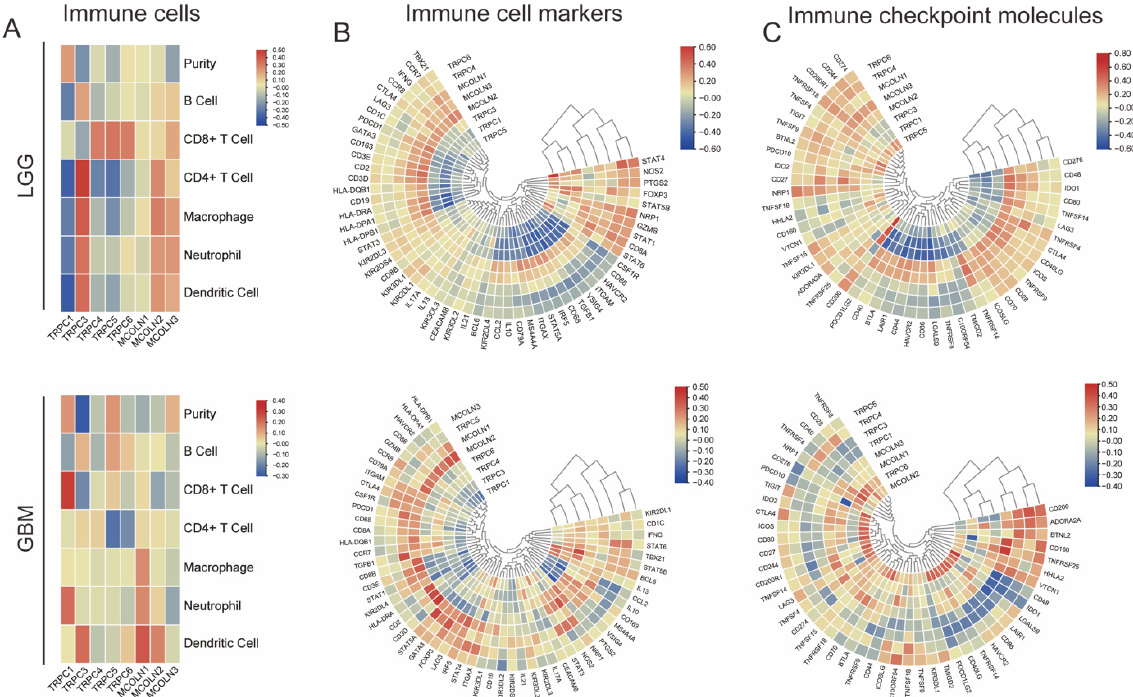
Figure 7. Hub genes are associated with immune activation in glioma. Heatmap represents the correlations between hub genes of TRPs family and 6 infiltrating immune cells ( A ), 56 immune cell markers ( B ), and 47 immune checkpoint molecules ( C ) in GBM and LGG.